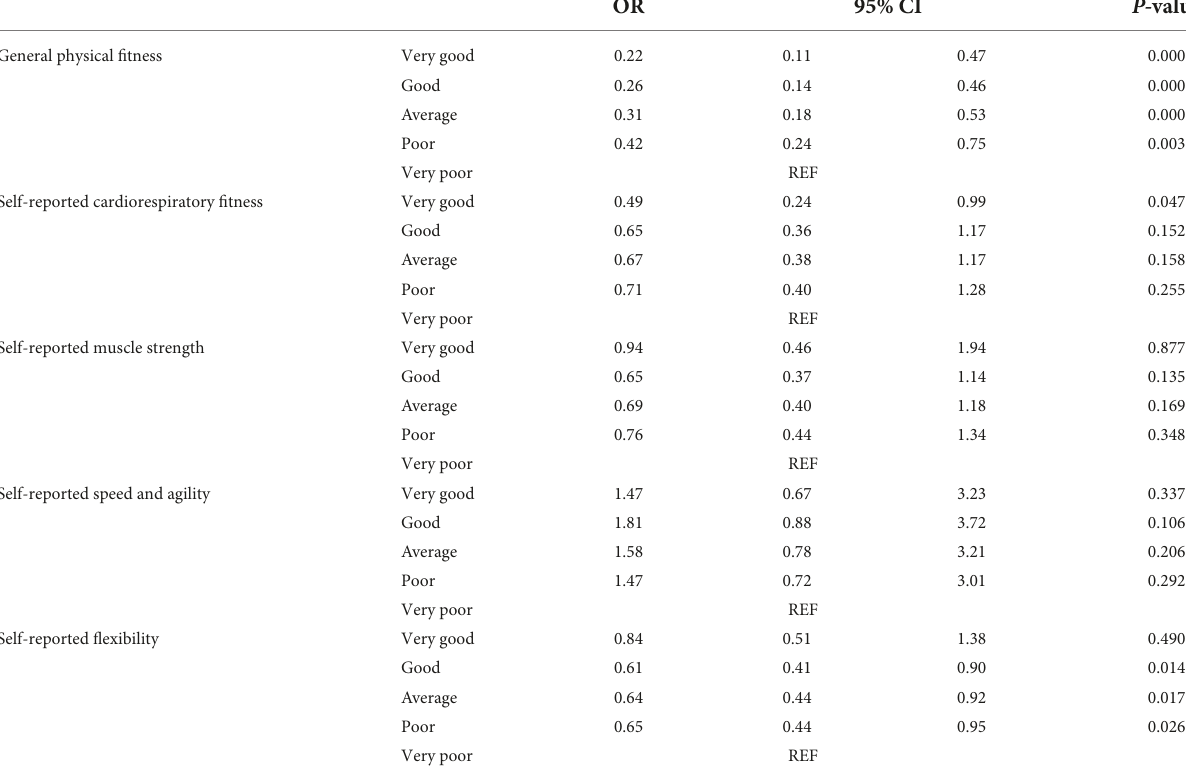
TABLE 7 The association between self-reported physical fitness and anxiety.